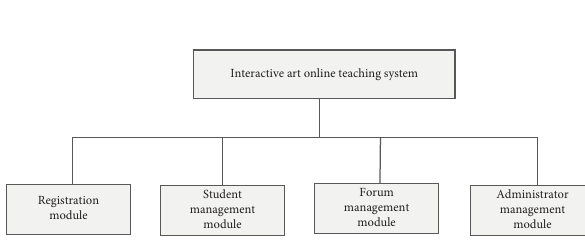
Figure 2: Overall structure module of the